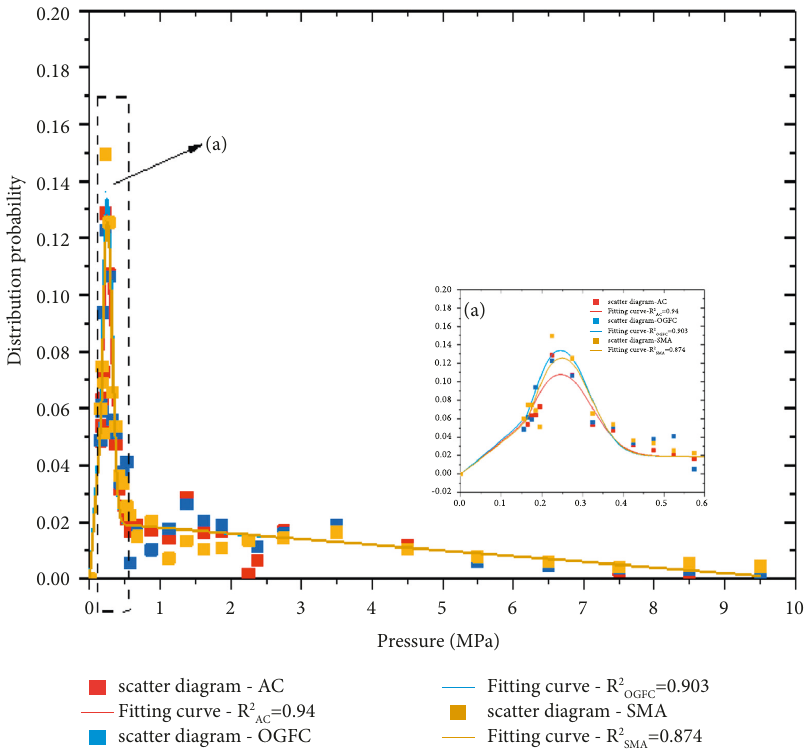
Figure 10: The measured distribution of particle contact stress in